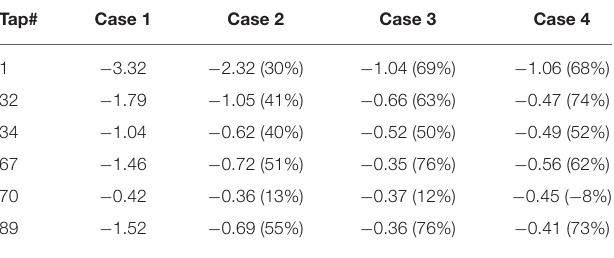
TABLE 1 | C p mean for selected taps at the wind direction of 45 degrees.